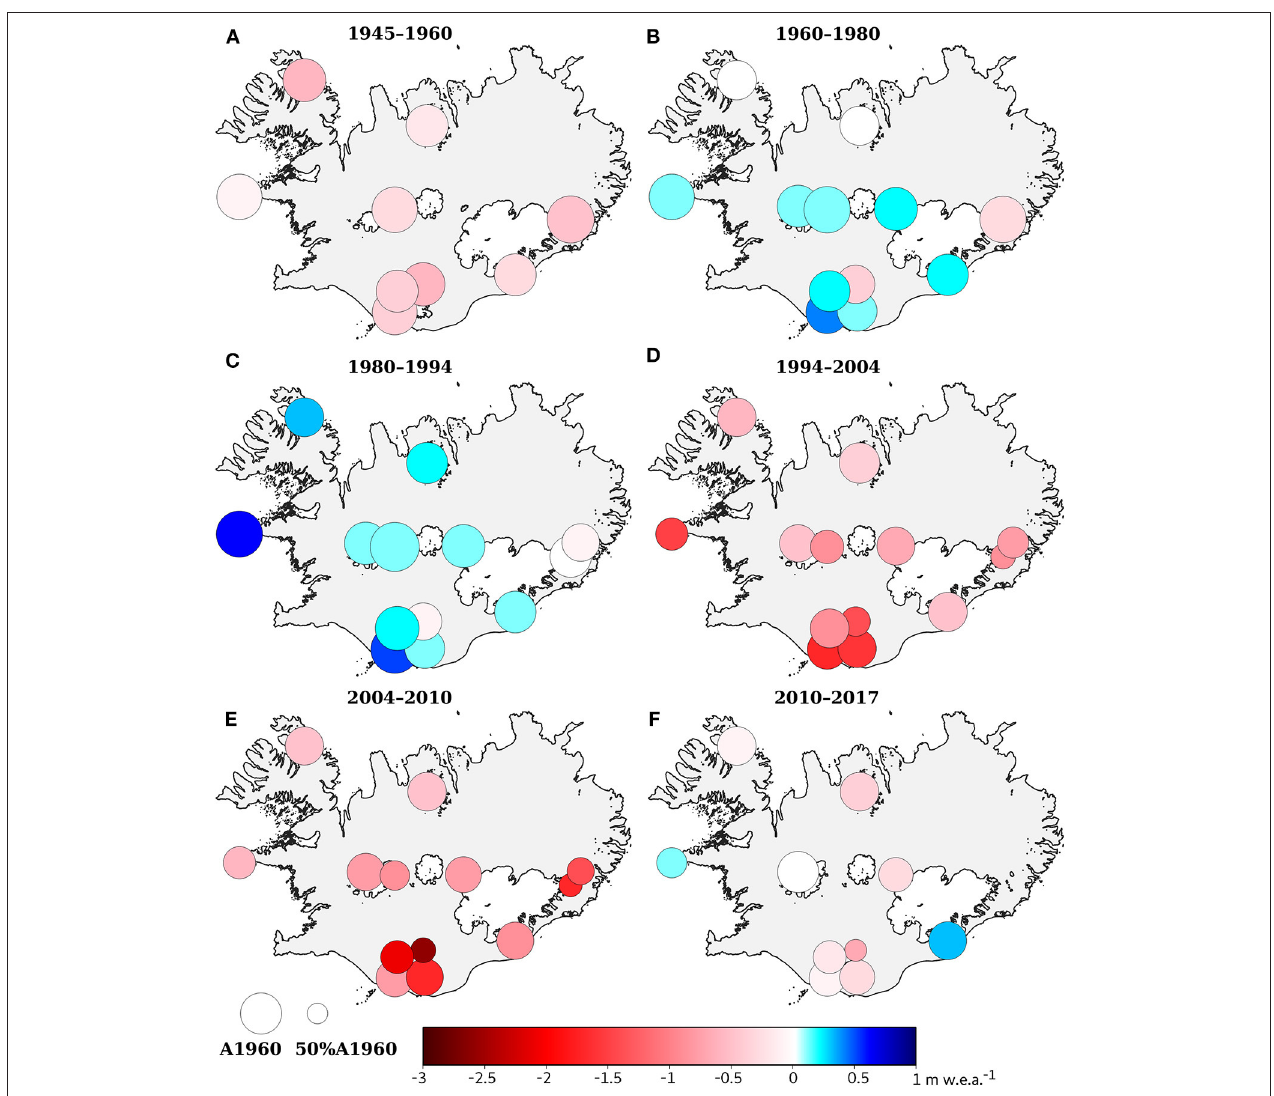
FIGURE 4 | Glacier-wide geodetic mass balance for six time periods between 1945 and 2017. (A) 1945–1960. (B) 1960–1980. (C) 1980–1994. (D) 1994–2004. (E) 2004–2010. (F) 2010–2017. Red and blue colors indicate negative and positive mass balance, respectively. The size of each circle shows the ratio of area changes relative to 1960. Tabulated values of temporally homogenized mass balance and associated uncertainties (95% confidence level) are shown in Table S2